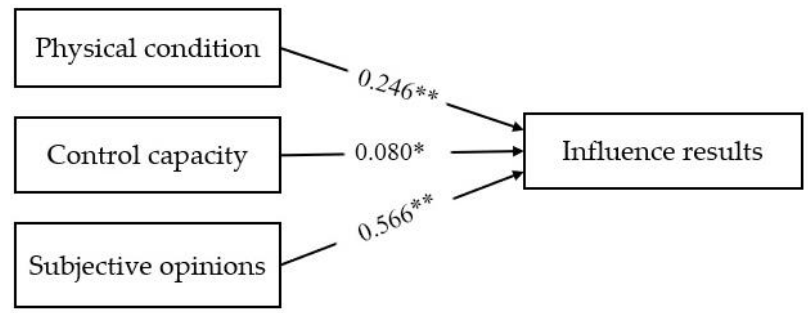
Figure 9. Regression coefficient model diagram (* indicates p < 0.05 while ** means p < 0.01)